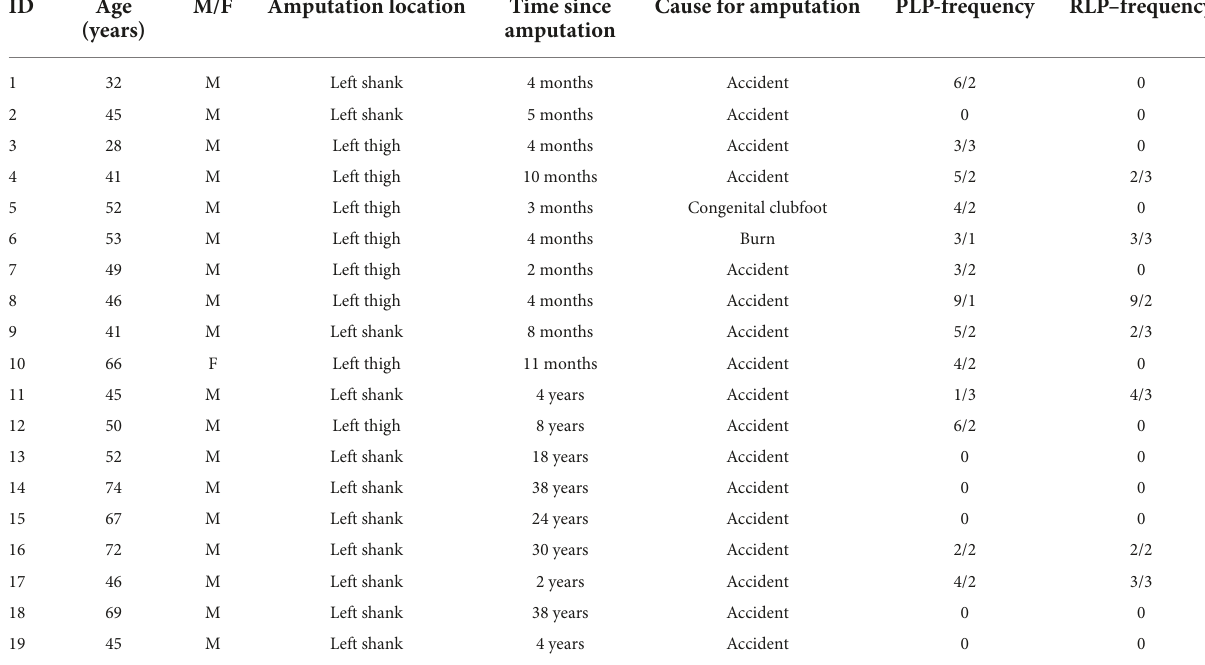
TABLE 1 Demographic and clinical details of the